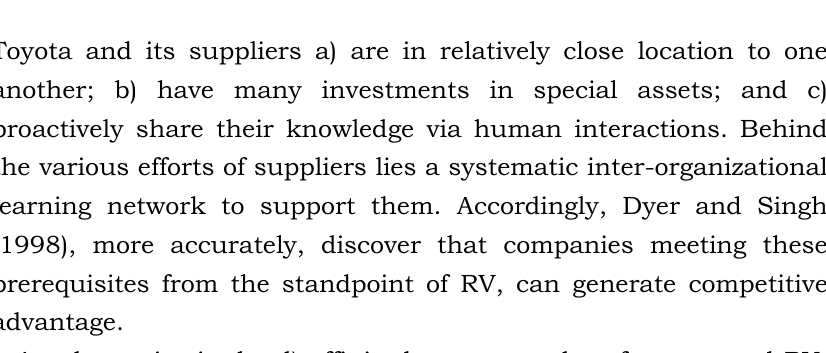
Figure 1. Relational view: Four prerequisites of competitive